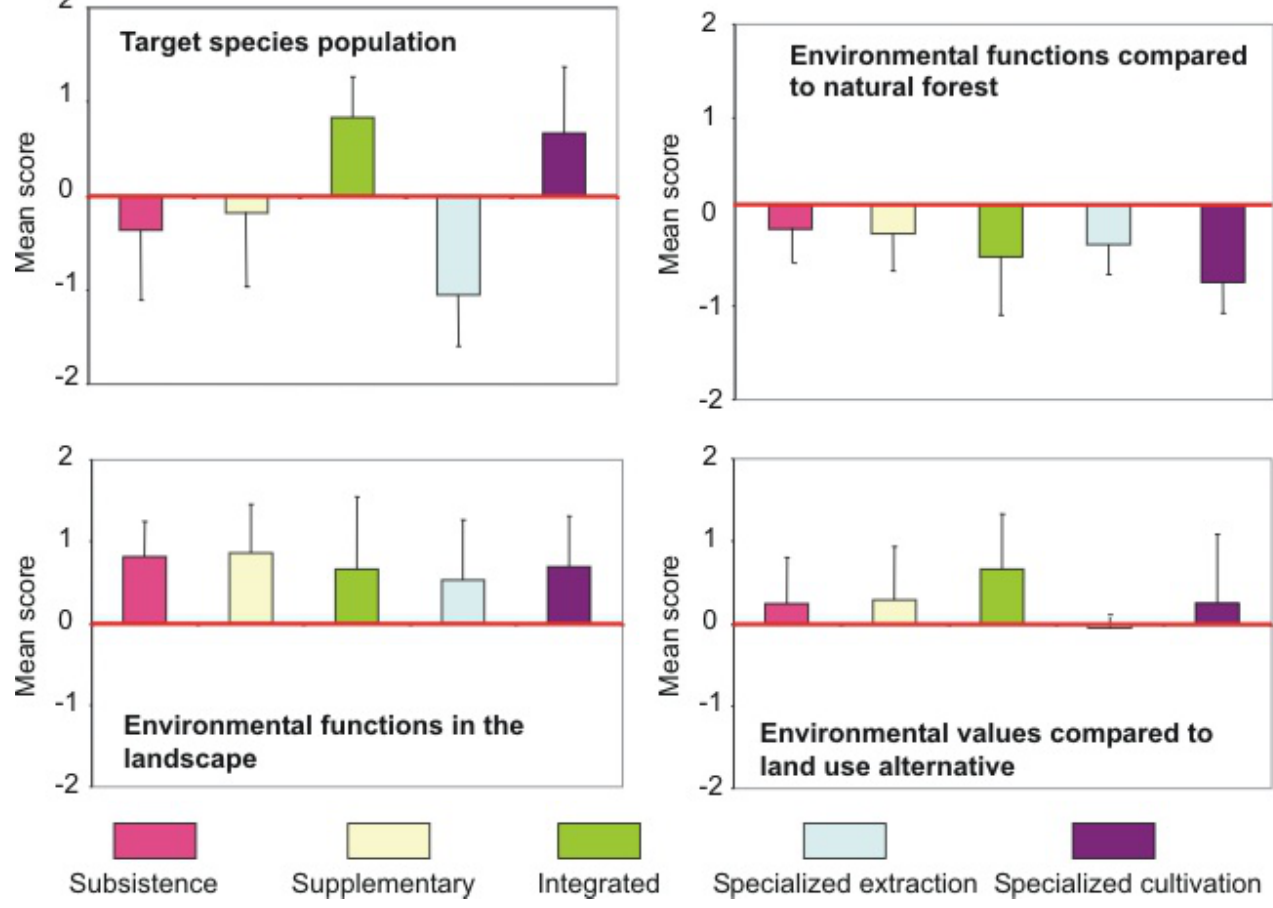
Fig. 5. Environmental outcomes of different livelihood strategies. The bars represent the mean and the lines represent the standard